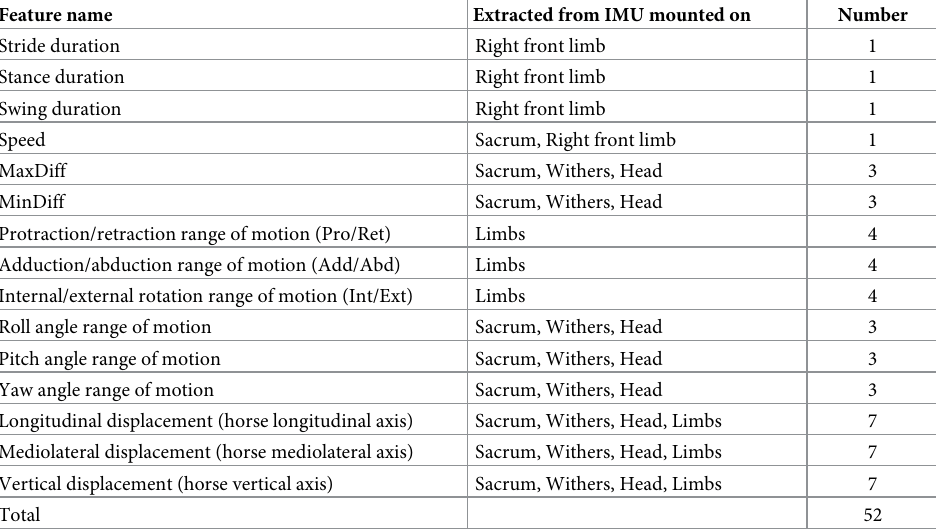
Table 2. Extracted features from